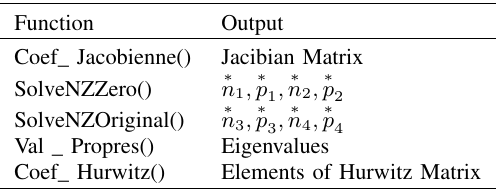
TABLE III: NPZ _ Sympy_